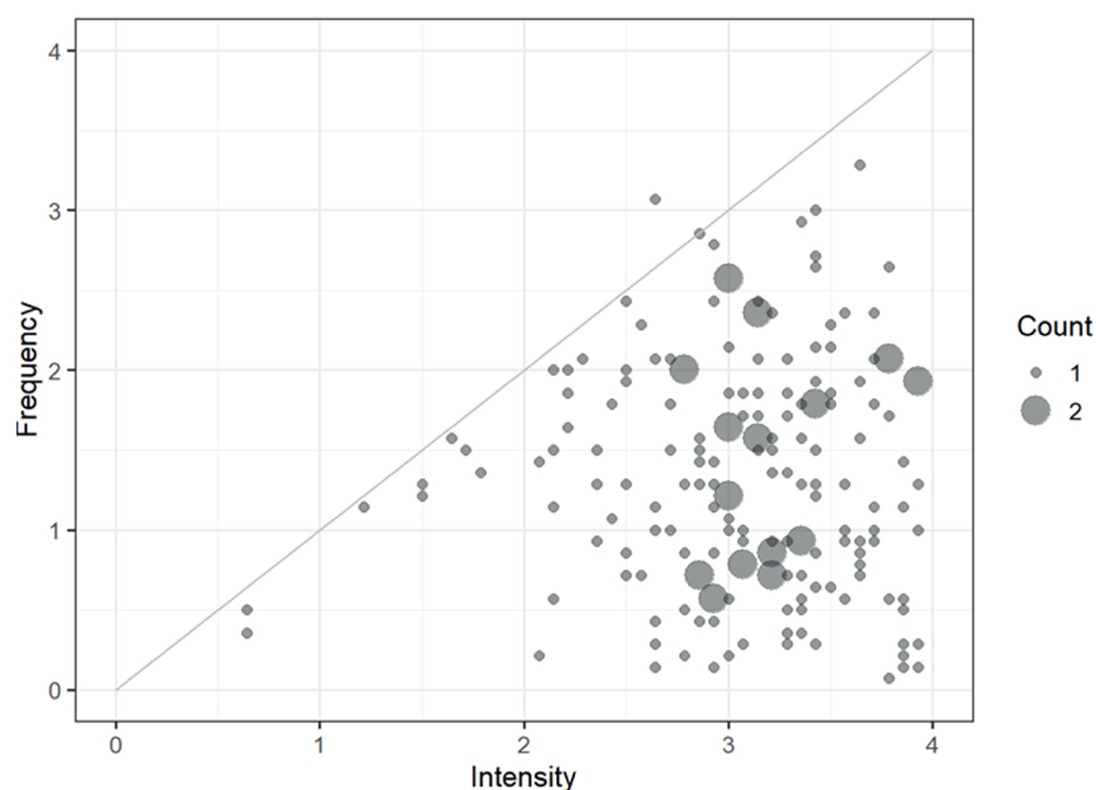
Figure 2. Italian Pediatric MDS-R results. Each subject’s overall intensity and frequency score were calculated, both as the average responses on the corresponding scale. The two resulting total scores were compared by placing them on a scatterplot where each dot represents a subject. When several subjects have the same value, the diameter of the corresponding dot increases in proportion to the number of subjects (Count). Almost all the points lay below the diagonal, mainly occupying the lower right quadrant highlighting that the intensities are generally high and the frequencies low.